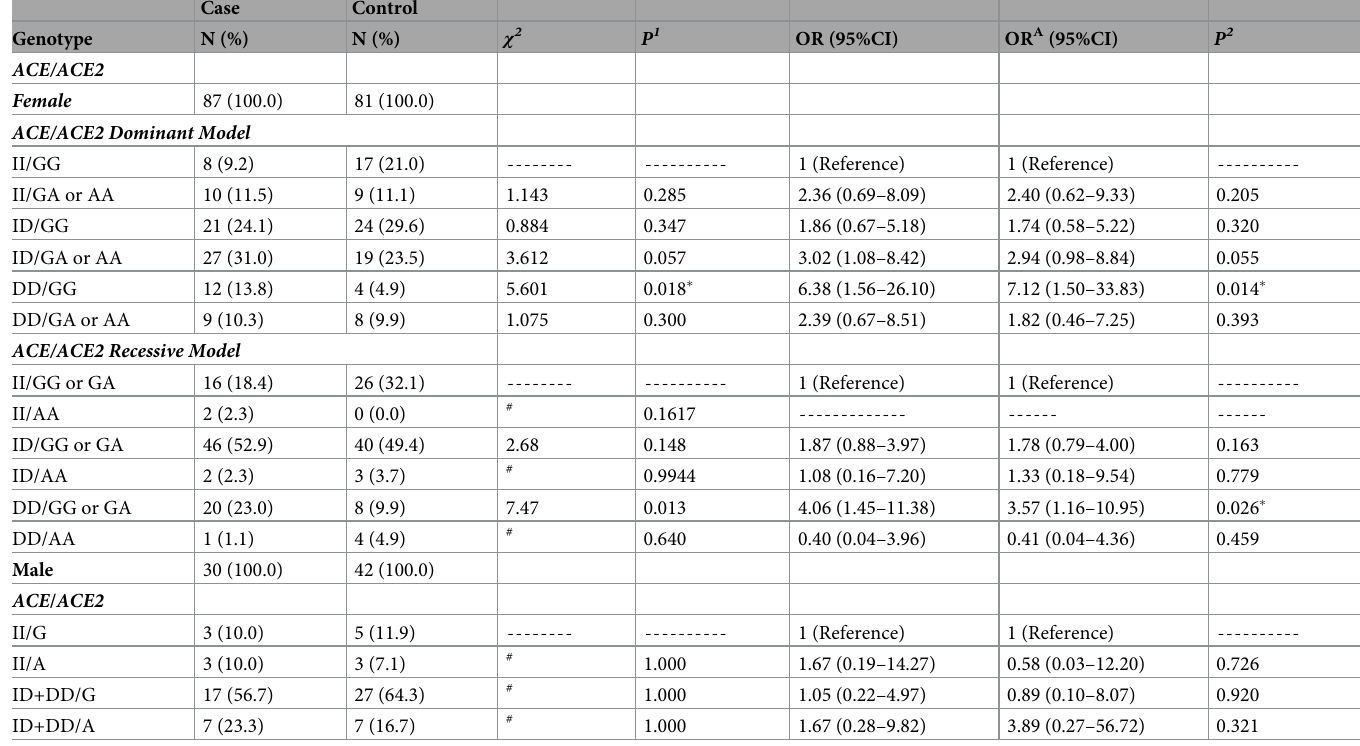
Table 3. Distribution of genotypic frequencies for the combination of ACE I/D polymorphism and ACE2 G8790A polymorphism in the study population and a risk analysis for